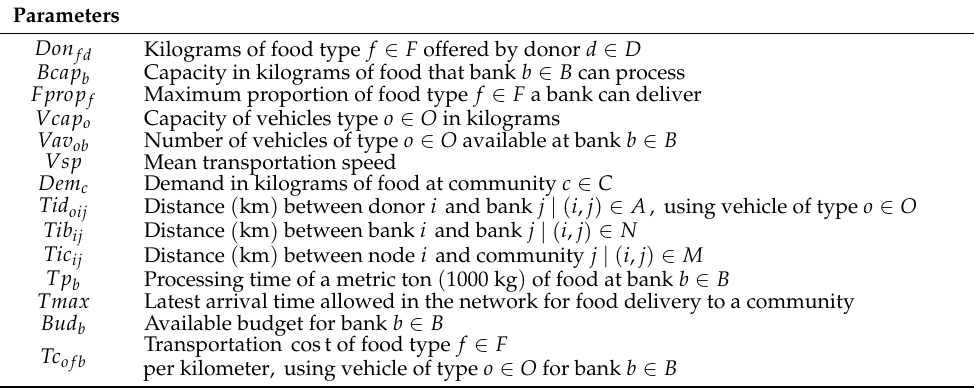
Table 4. Parameters used in the model